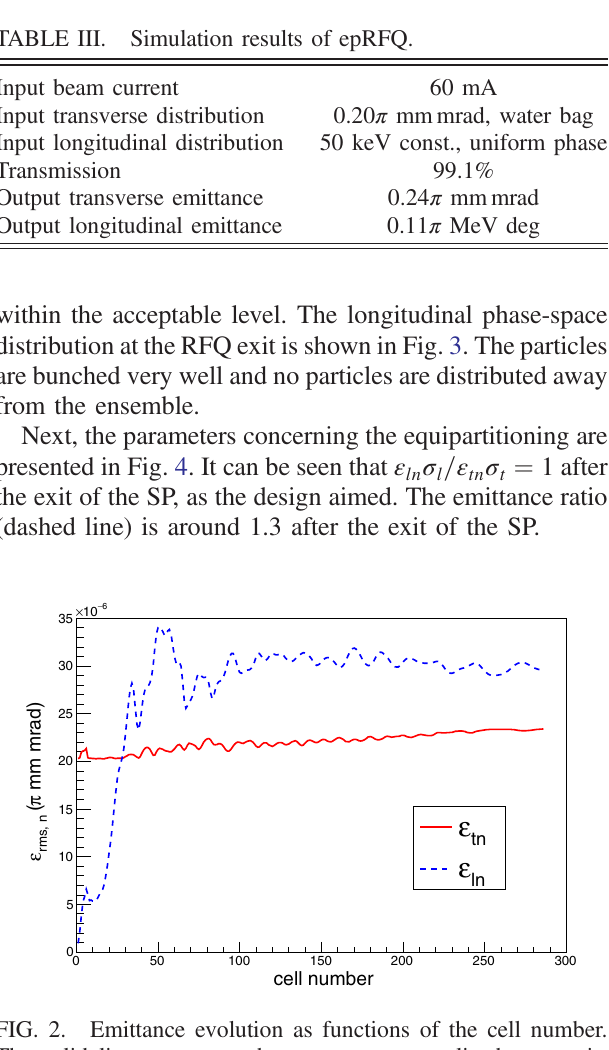
FIG. 2. Emittance evolution as functions of the cell number. The solid line represents the transverse normalized rms emit- tance, and the dashed line is the longitudinal one.